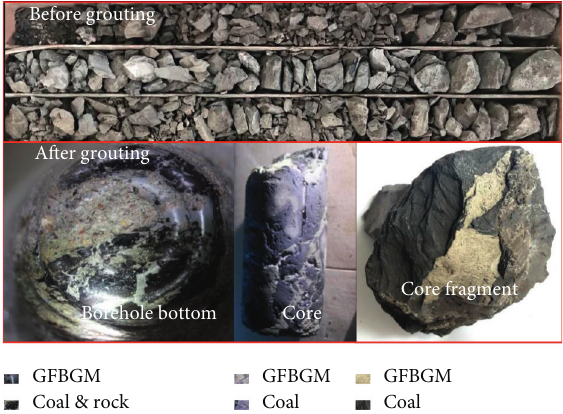
Figure 10: Borehole core samples before and after